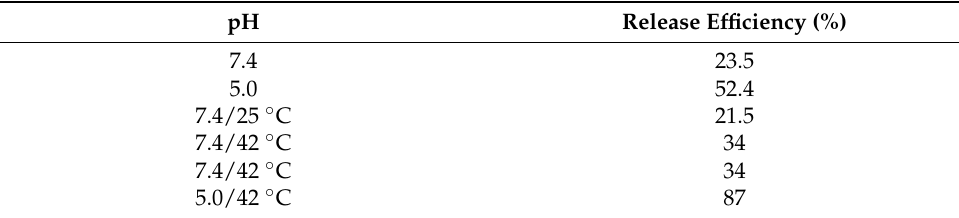
Table 2. PH and temperature-responsive drug delivery from the FeNP@MSHC/Dox